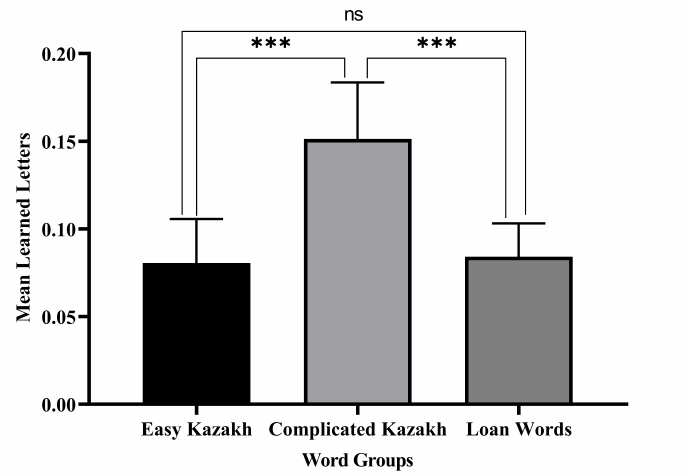
Figure 1. Mean values of learned letters by word categories in Experiment 1. p -values larger than 0.05 are summarized as “ns” (not significant), while p -values less than 0.001 are given three asterisks (***) to denote significance, as shown in the Wilcoxon